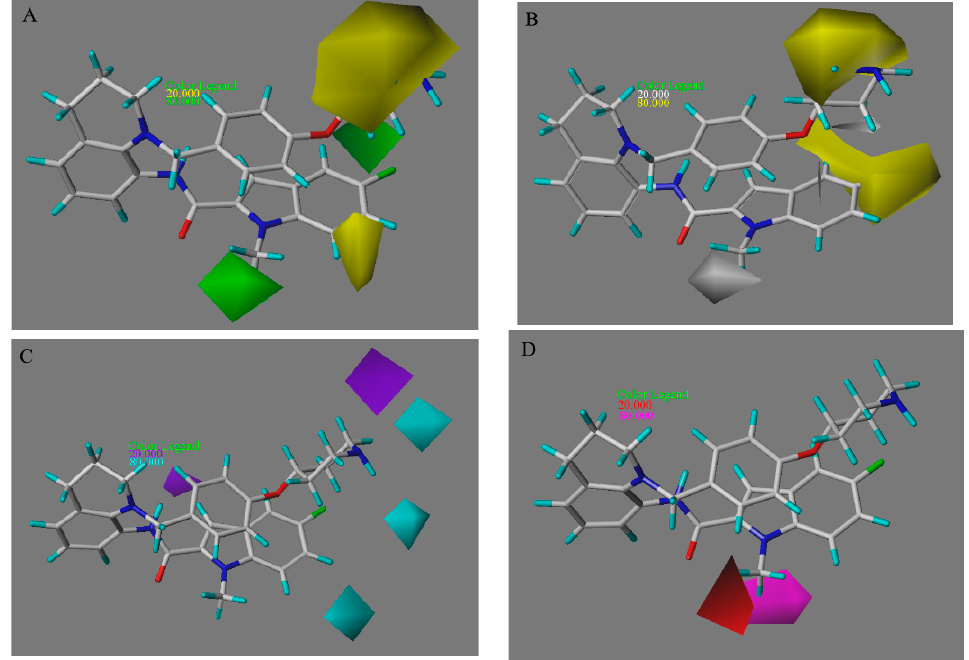
Figure 4. The CoMSIA model contour maps with compound 18x as the reference. ( A ) The steric field. ( B ) The hydrophobic field. ( C ) The hydrogen bond donor field. ( D ) The hydrogen bond acceptor field.